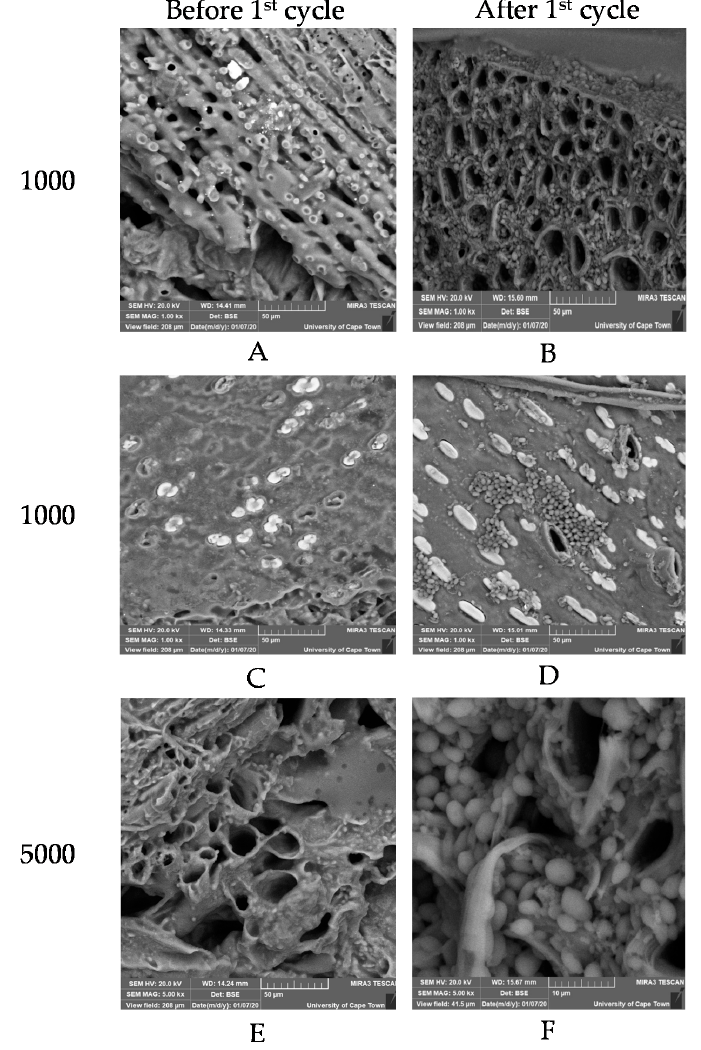
Figure 6. Scanning electron micrographs of corncobs before and after first cycle fermentations at 1000× ( A – D ) and 5000× ( E , F ) magnifications.